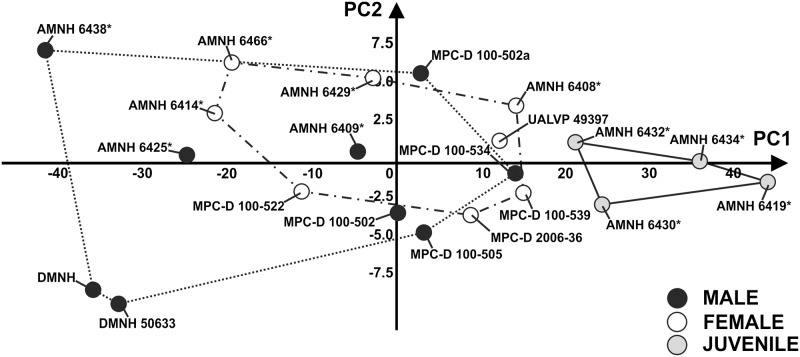
Principal Component Analysis performed on the linear measurements of skulls.The continuous line represents “juvenile” morphospace. The dotted line represents “male” morphospace and the dashed line represents “female” morphospace. Asterisks indicate specimens shared with Dodson [25].